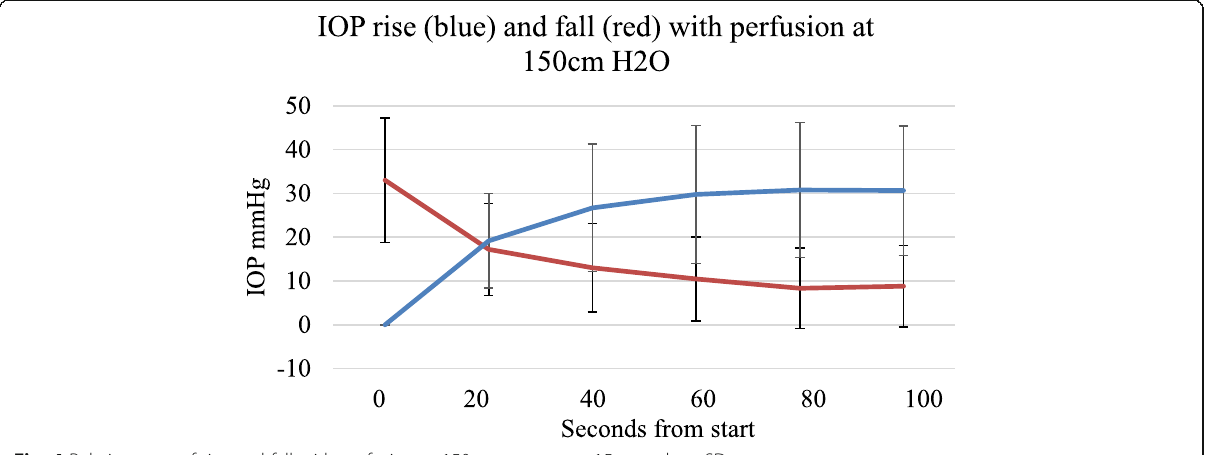
Fig. 4 Relative rates of rise and fall with perfusion at 150 cm serum, n = 15, error bars SD